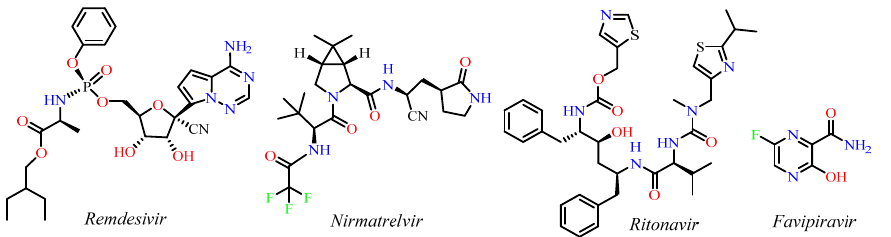
Figure 1. Structures of antiviral drugs against the SARS-CoV-2 virus that have or had clinical